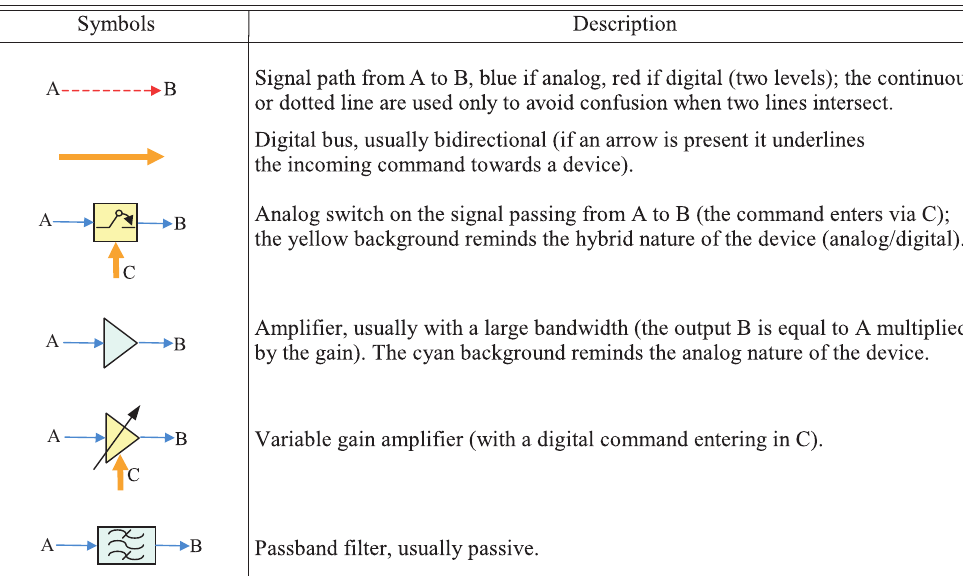
Table II. Symbols used in the block